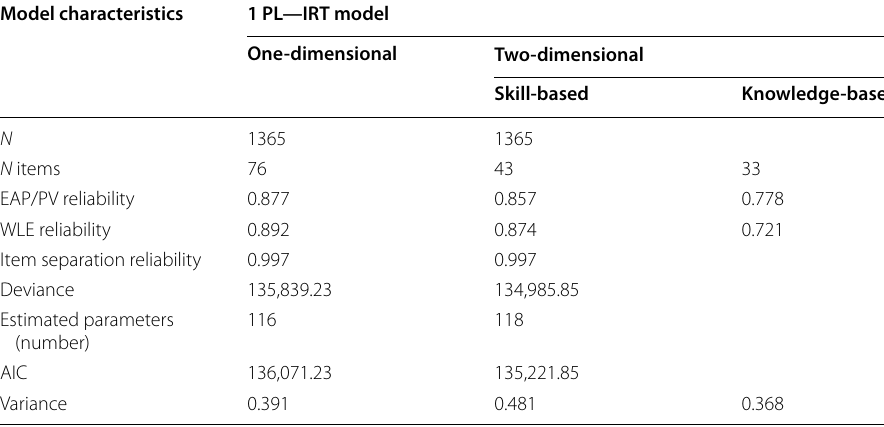
Calculation on the basis of the Gauss‑Hermite Quadrature with 225 nodes